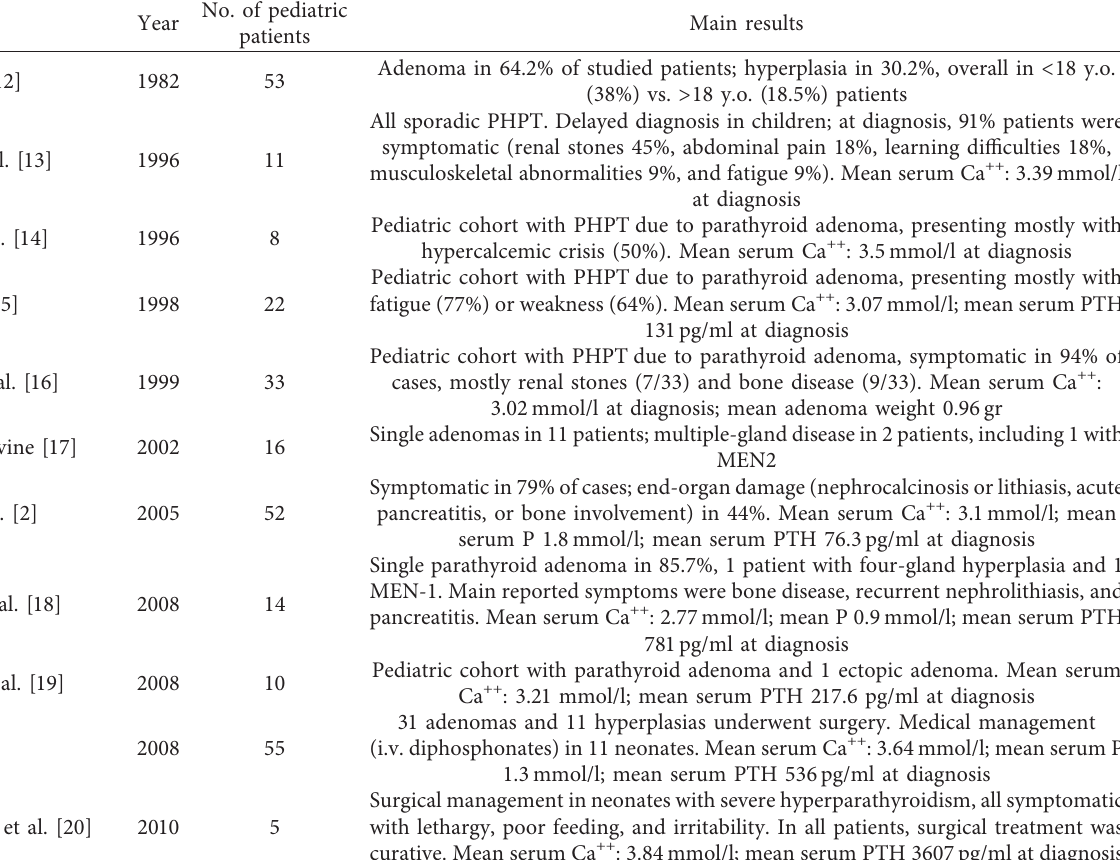
Table 2: Main papers reporting patients with PHPT in the pediatric